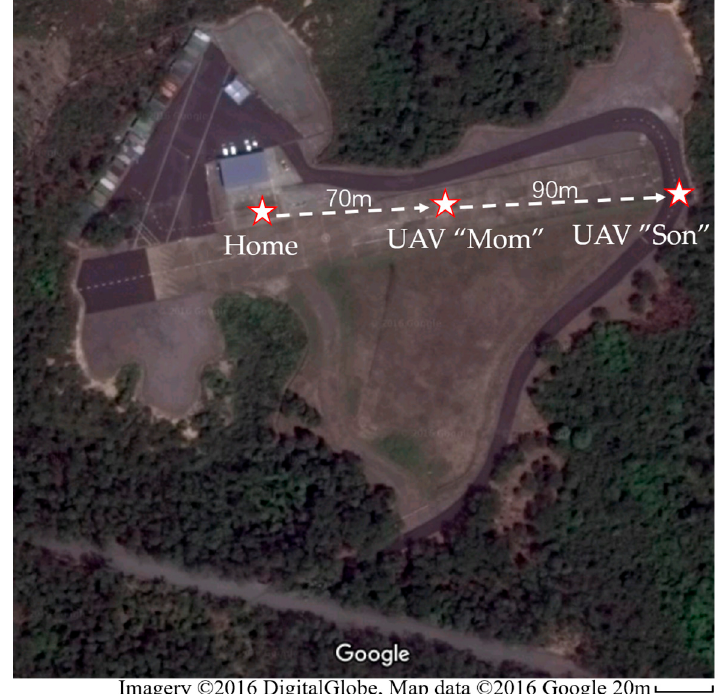
Figure 19. Final positions of nodes in the Google map in the extended distance test in Hong Kong.